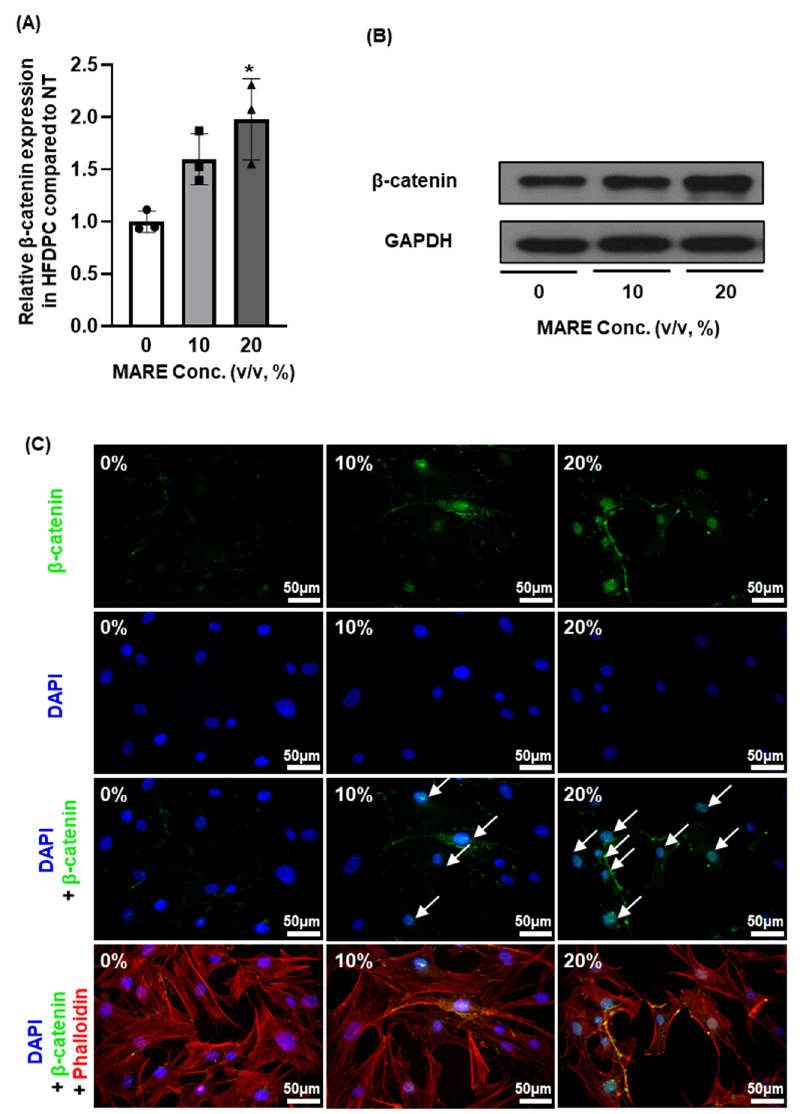
Figure 5. Effect of MARE on β -catenin activation in the HFDPCs. ( A ) Relative β -catenin expression in HFDPC assessed using qRT-PCR ( n = 3, * p < 0.05). ( B ) Representative β -catenin protein expression in the HFDPC assessed using Western blotting. ( C ) Immunocytochemistry (ICC) of β -catenin (green) staining merged with DAPI (nucleus, blue) and phalloidin (F-actin, red) signals.